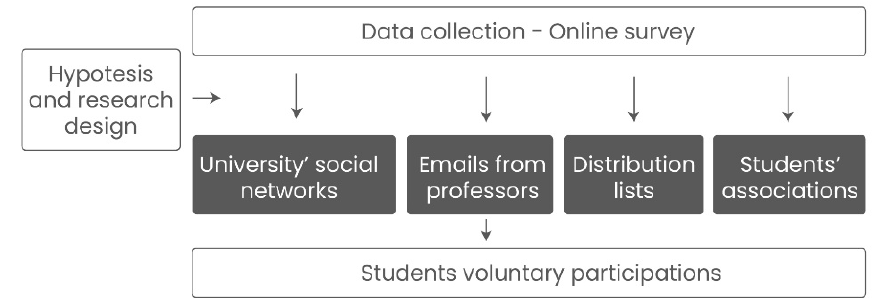
Figure 2. Study design.